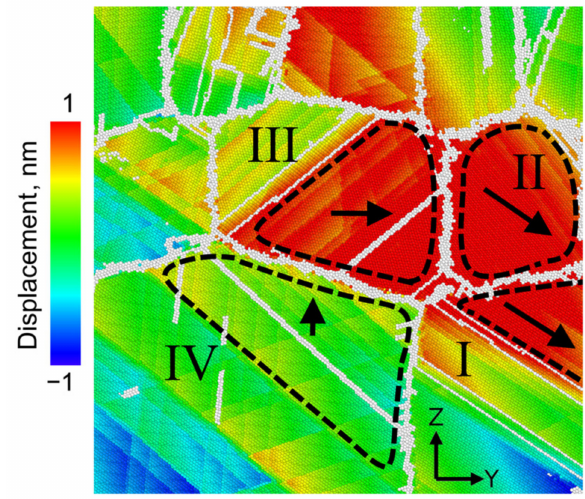
Figure 9. GB sliding pattern in a sample fragment in the cross section at X = 49 nm for strain 15.0%. The arrows indicate the scaled average displacement vectors for the outlined areas. Atoms are colored according to the Y component of their displacement. Atoms belonging to GBs and structural defects are marked in light